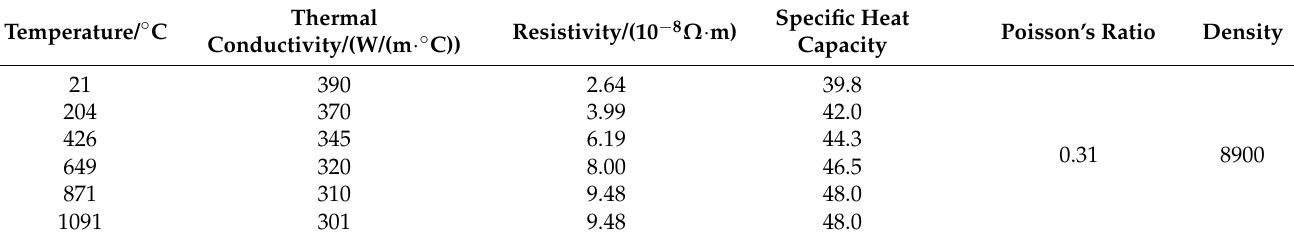
Table 2. Physical properties of chromium-zirconium copper